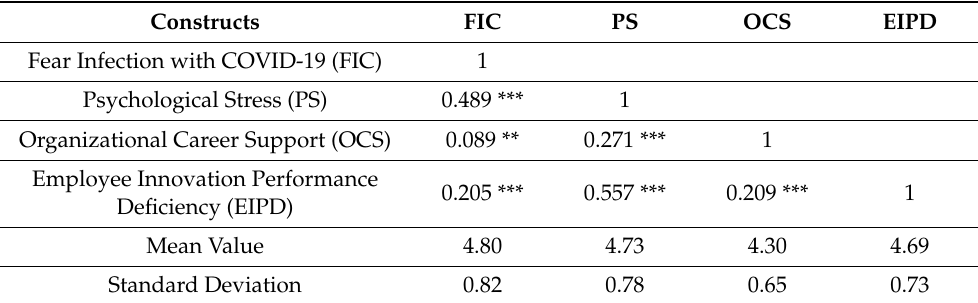
Table 3. Correlations and descriptive statistics (mean, and standard deviation) ( n =